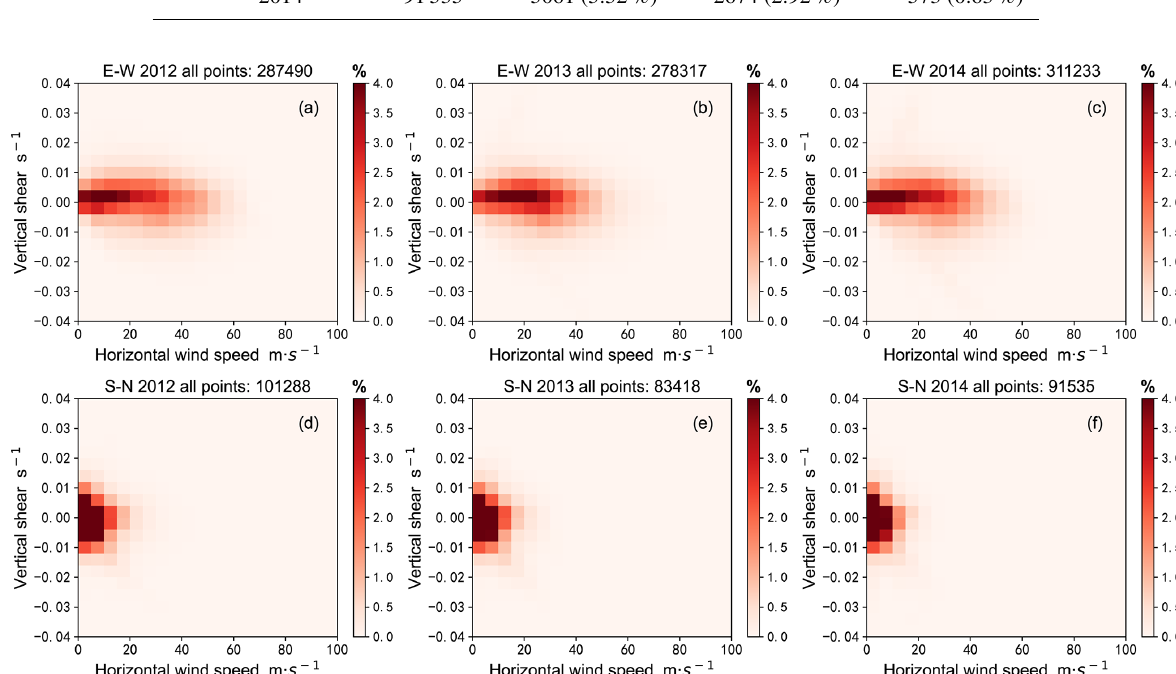
Figure 1. Two-dimensional frequency distribution characteristics of horizontal wind speed and vertical shear of horizontal wind speed within the height range of 3–19.8km above the Beijing MST radar station from 2012 to 2014. (a, b, c) The east–west component of horizontal wind (d, e, f) the north–south component of horizontal